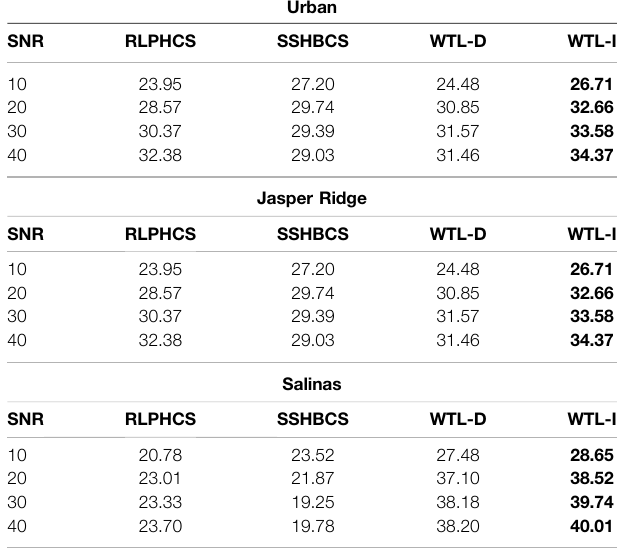
TABLE 3 | PSNR of reconstructed images with SSHBCS, RLPHCS, WTL-D, and WTL-I at different noise levels and 20 % SR (best results are